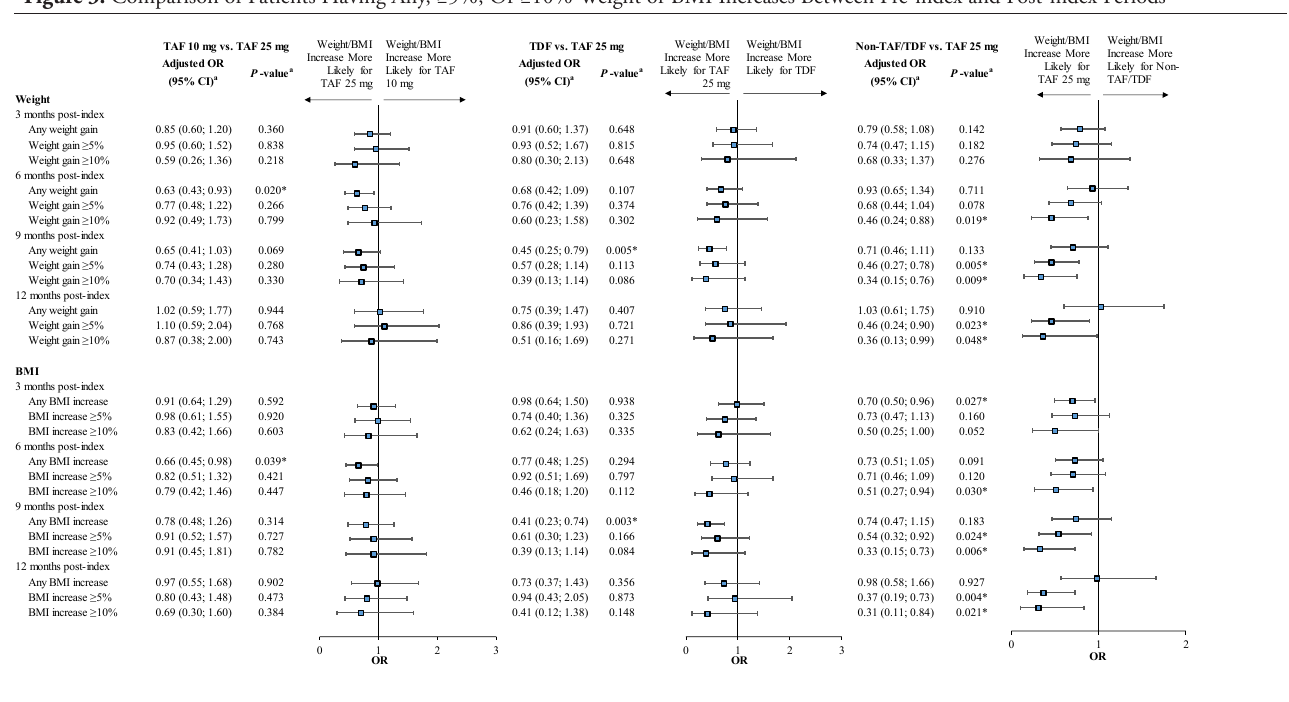
Figure 3. Comparison of Patients Having Any, ≥5%, Or ≥10% Weight or BMI Increases Between Pre-index and Post-index